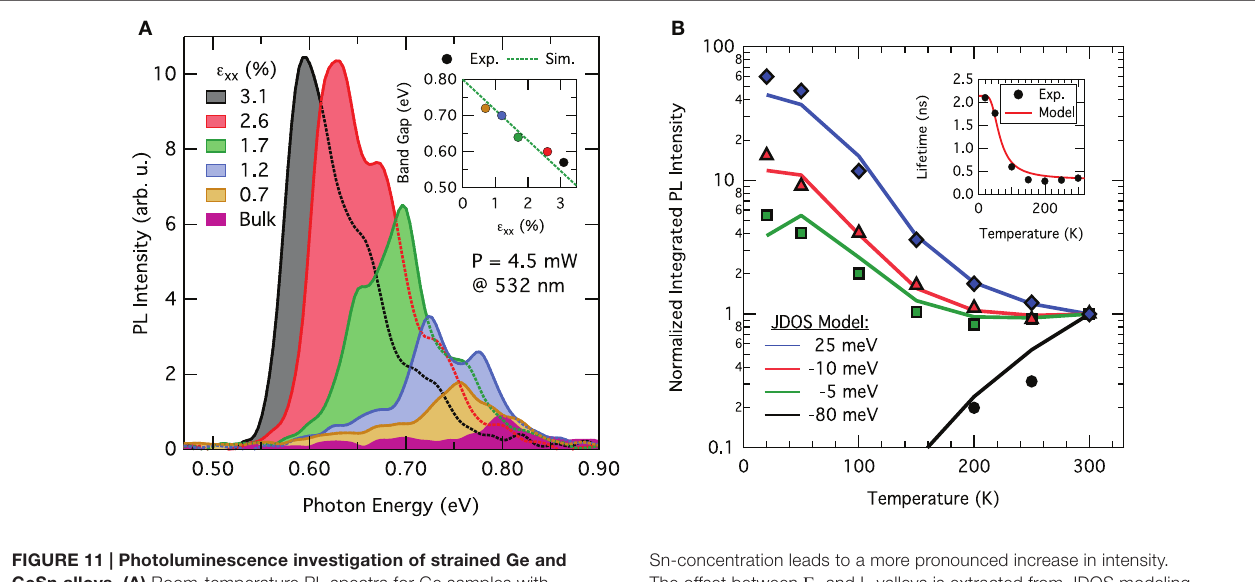
FiGURe 11 | Photoluminescence investigation of strained Ge and GeSn alloys . (A) Room-temperature PL spectra for Ge samples with increasing uniaxial strain up to 3.1%. The inset shows the good agreement between the experimental and modeled band edges. (B) Temperature- dependent integrated PL intensity normalized to unity at 300 K for a series of GeSn layers with Sn-content ranging from 8 to 13%. An increase in